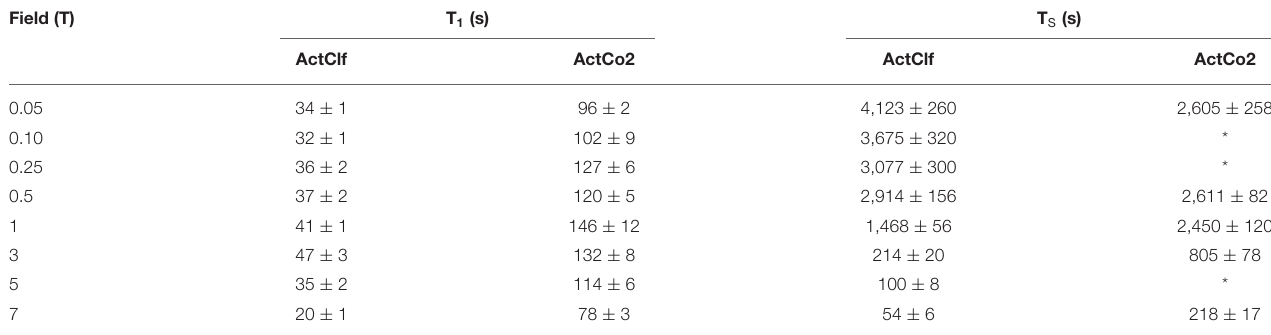
TABLE 4 | T 1 and T S values for samples ActClf and ActCo2 obtained at 20 ◦ C and different magnetic field